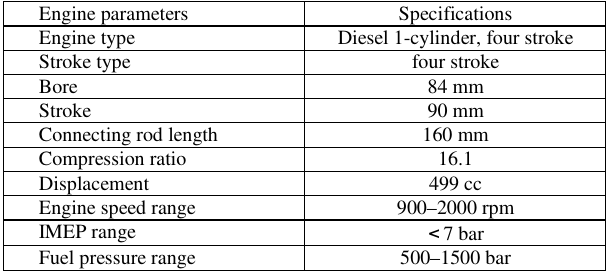
Table 1. Research engine specifications Engine parameters